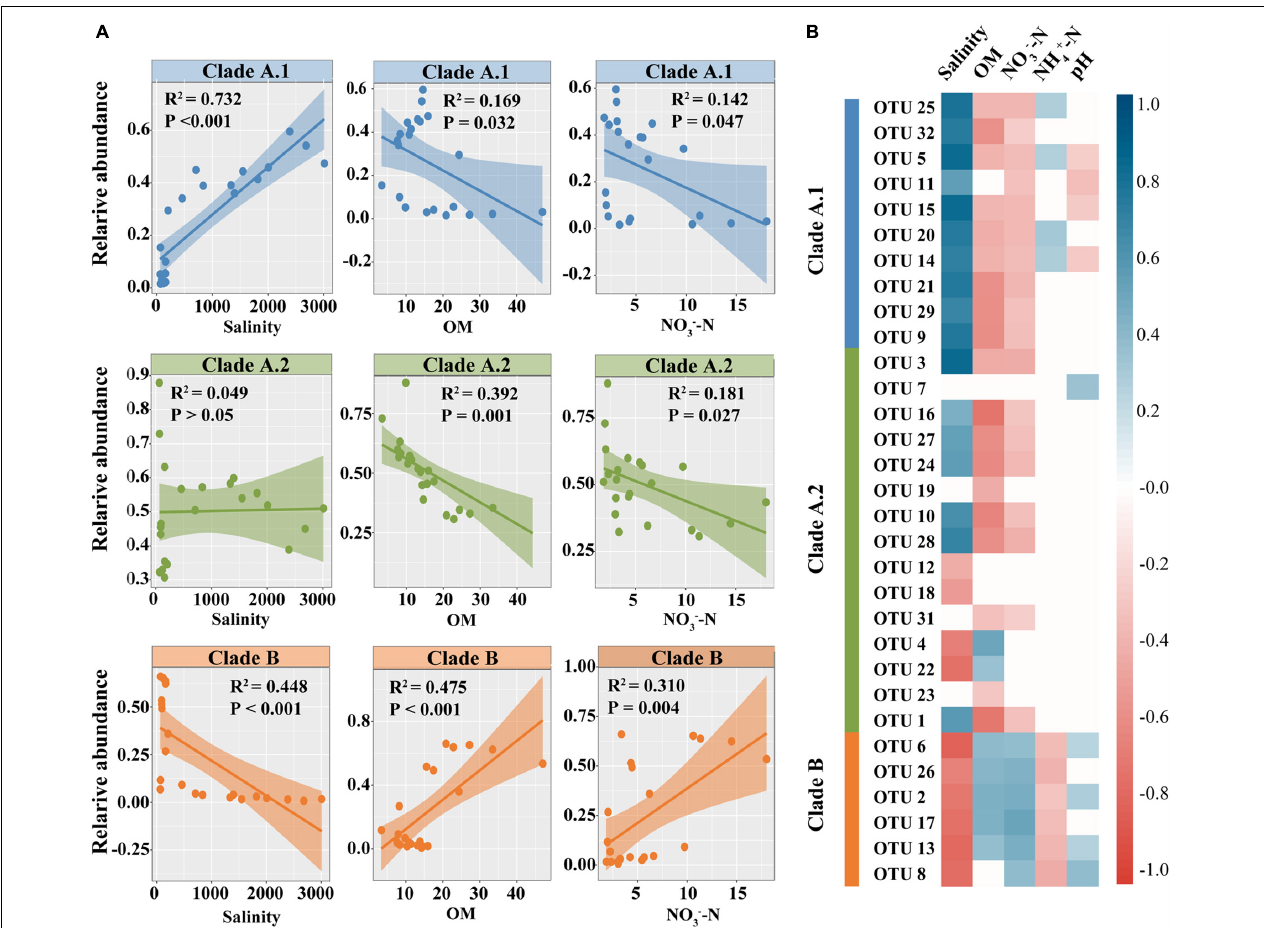
FIGURE 5 | Relationships between relative abundance of comammox Nitrospira and soil properties. (A) Linear regression analysis between relative abundance of different comammox clades and environmental properties. (B) Spearman correlations of dominant OTUs (abundance > 1%) with soil properties in all samples, displayed as heatmaps. Color bar indicates correlation coefficients. Only significant correlations ( P < 0.05) were shown.